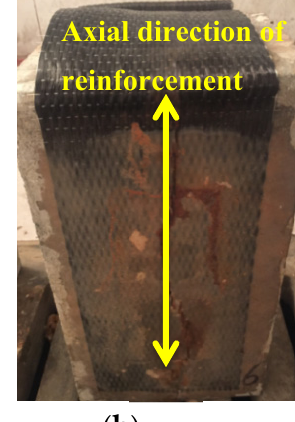
Radial direction of steel bar